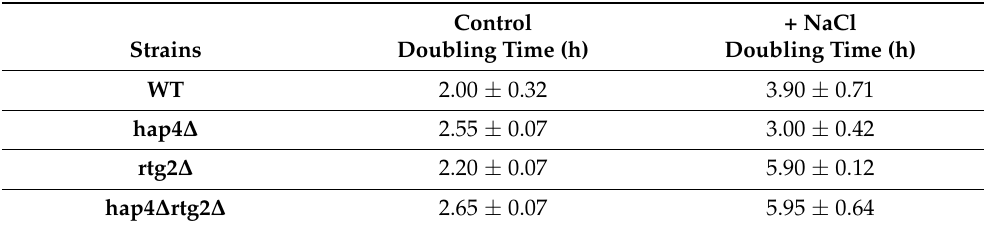
Table 1. Doubling time of wild type (WT) and mutant cells grown in the absence (control) and in the presence of sodium chloride (0.8 M NaCl). Reported data are the mean ± standard deviation of three independent experiments, each performed in triplicate.